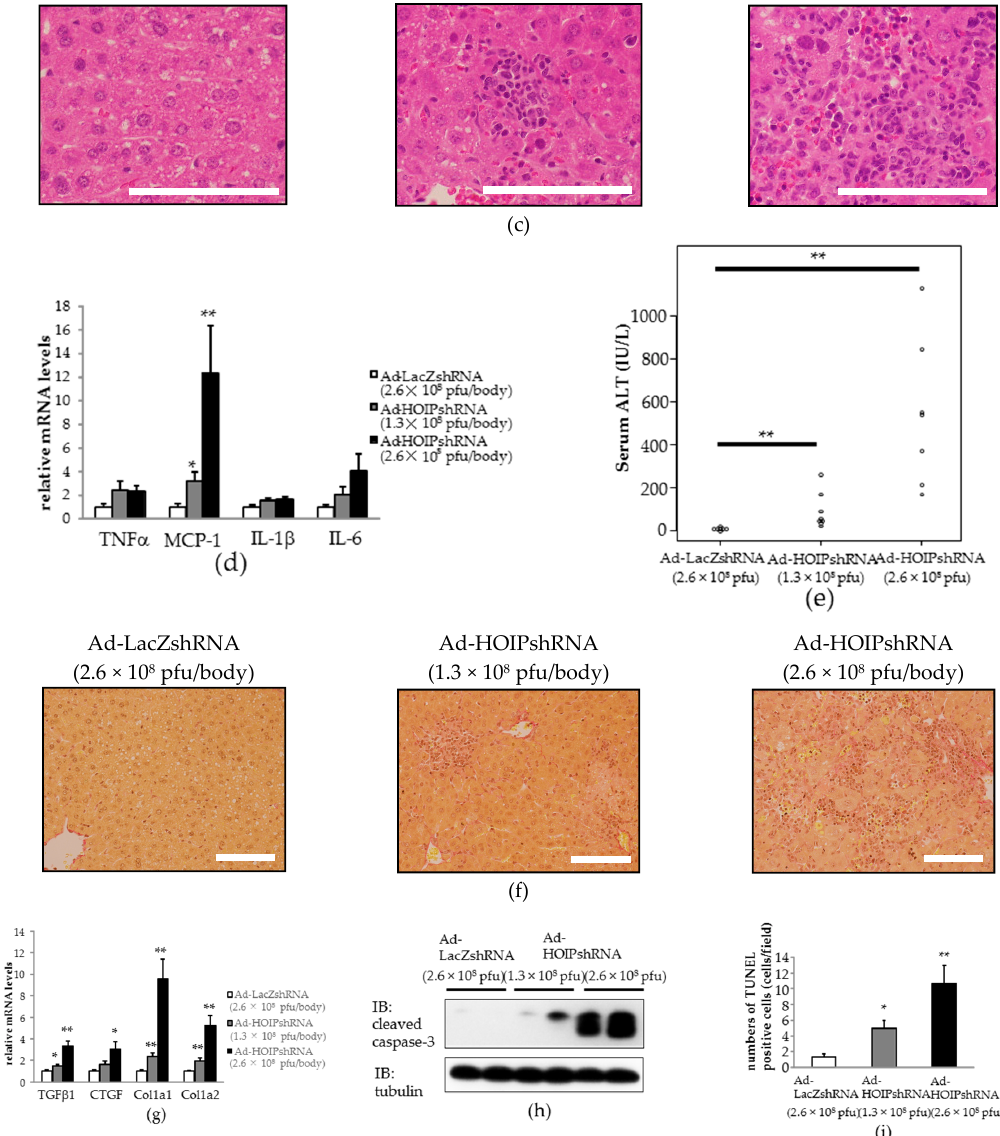
Figure 3. HOIL-1L interacting protein (HOIP) knockdown induces hepatocyte apoptosis, severe inflammation, and fibrosis, without steatosis in the liver. ( a ) Immunoblotting of each LUBAC component in the liver. ( n = 4) (* p < 0.05, ** p < 0.01); ( b ) Liver lysates were fractionated by gel filtration and then subjected to immunoblotting of each LUBAC component. Arrows: objective bands, asterisks: non-specific bands. P: positive controls; ( c) H-E staining of the liver. Lower pictures are the enlarged versions of the framed portions. (Scale bar: 100 µm); ( d ) mRNA levels of inflammatory cytokines in the liver. ( n = 7–8) (* p < 0.05, ** p < 0.01); ( e ) Serum ALT level. ( n = 7–8) (** p < 0.01); ( f ) picrosirius red staining of the liver. Lower pictures are the enlarged versions of the framed portions. (Scale bar: 100 µm); ( g ) mRNA levels of profibrogenic cytokines in the liver. ( n = 7–8) (* p < 0.05, ** p < 0.01); ( h ) Immunoblotting of cleaved caspase-3 and tubulin, ( i ) TUNEL staining of the liver was performed and TUNEL-positive cells were counted in three randomly selected fields (magnification field 200×) in each mouse. (* p < 0.05, ** p < 0.01).